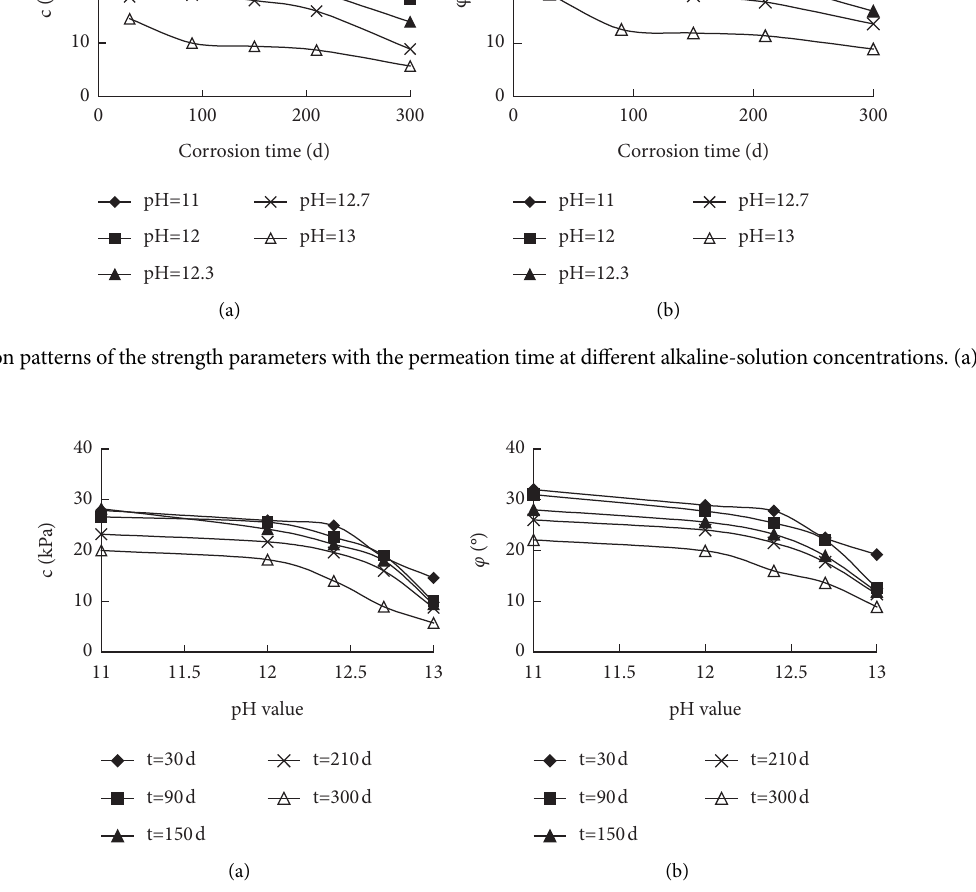
Figure 3: Variation patterns of the strength parameters with the alkaline-solution concentration after different permeation times. (a) c and (b) φ